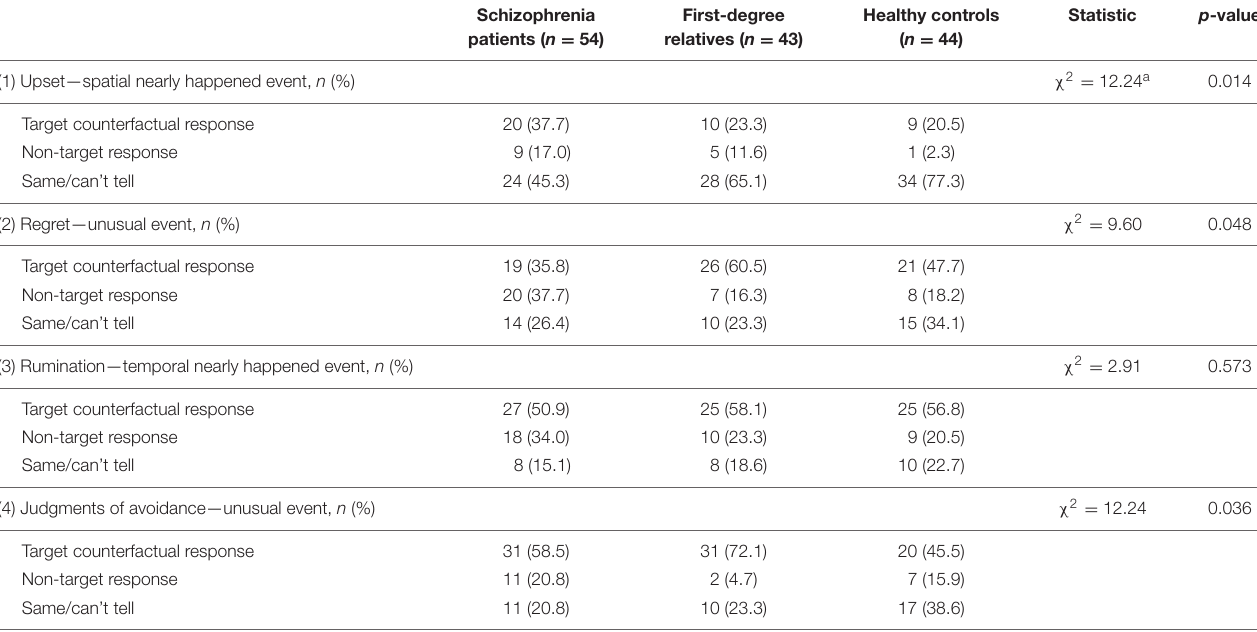
TABLE 6 | Descriptive and comparative analysis between groups on the CIT